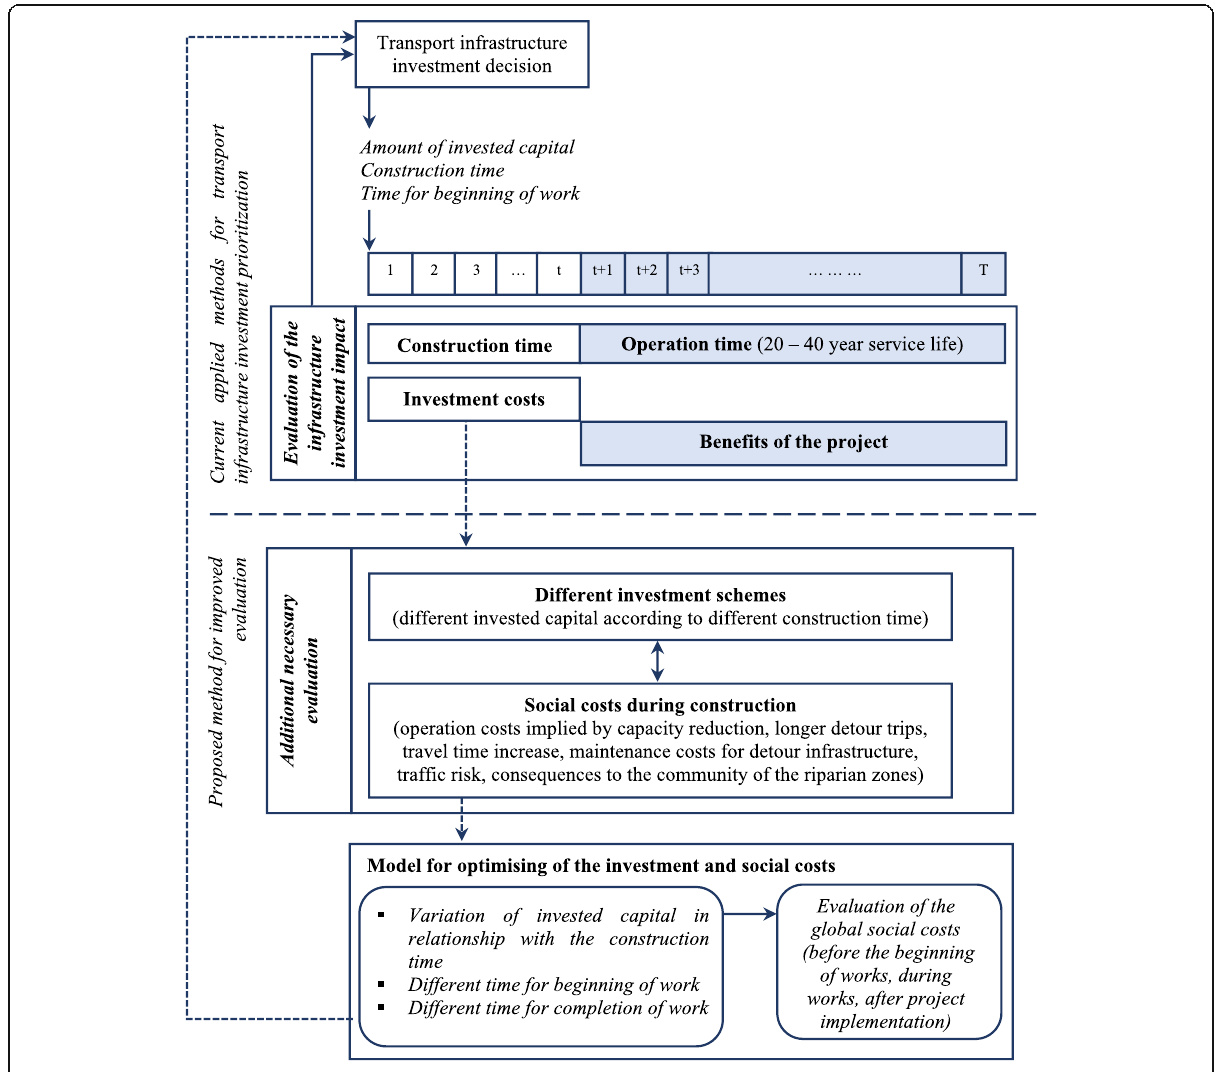
Fig. 2 Flowchart of procedures for transport infrastructure investment